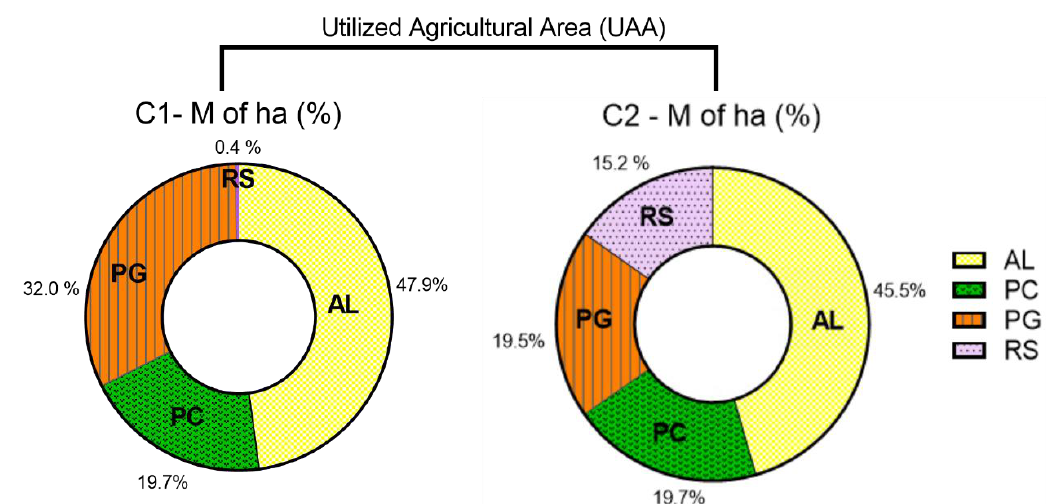
Figure 4. Percentage of surface occupied by the different crop groups (AL = arable land, PC = permanent crop, PG = permanent grass and RS = remaining surface) in relation to the total utilized agricultural area (UAA) for the two census dates (C1 and